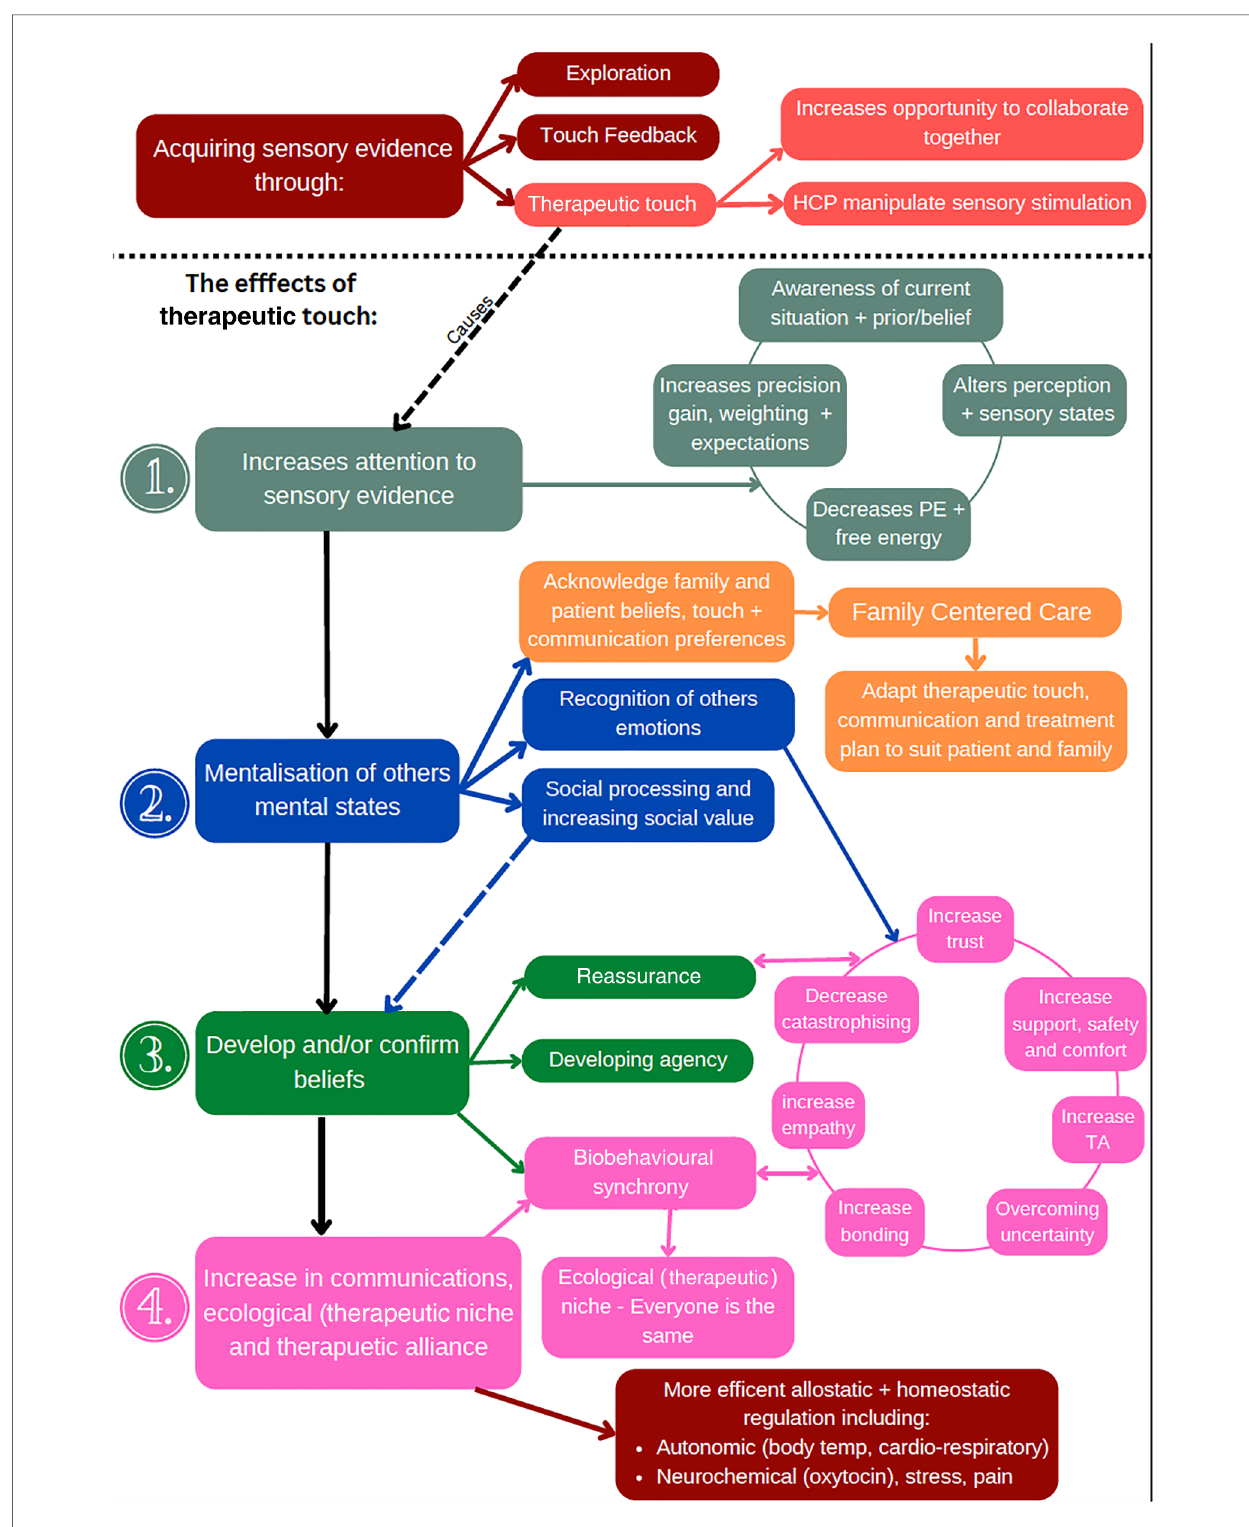
FIGURE 3 A map of the different processes involved in therapeutic